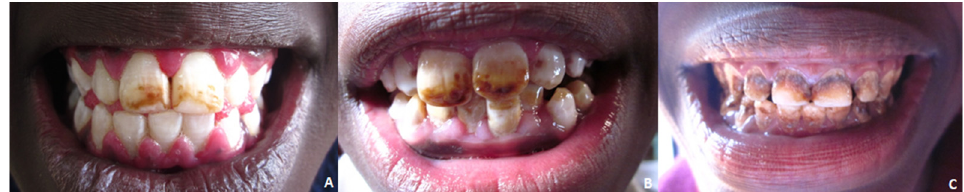
Figure 1. This figure depicts the severity of fluorosis: ( A ) mild fluorosis; ( B ) moderate fluorosis; ( C ) severe fluorosis.